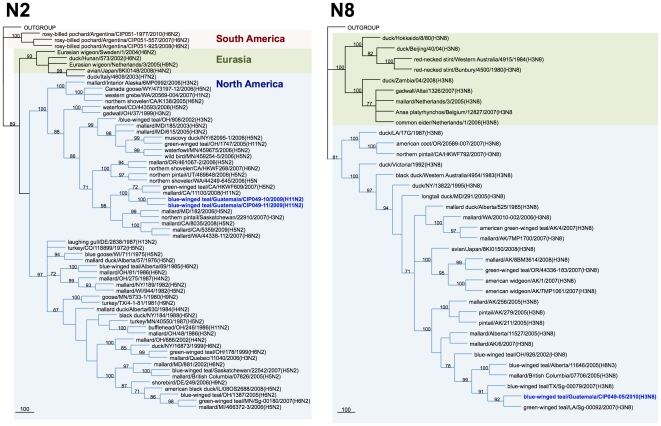
Phylogenetic trees for N2 and N8 NA genes.Trees were generated in PAUP 4.0b10 using Neighbor-Joining method with 1000 bootstrap replicates (bootstrap values above 70% are shown). Scale bar on the bottom-left indicates number of nucleotide substitutions per site.